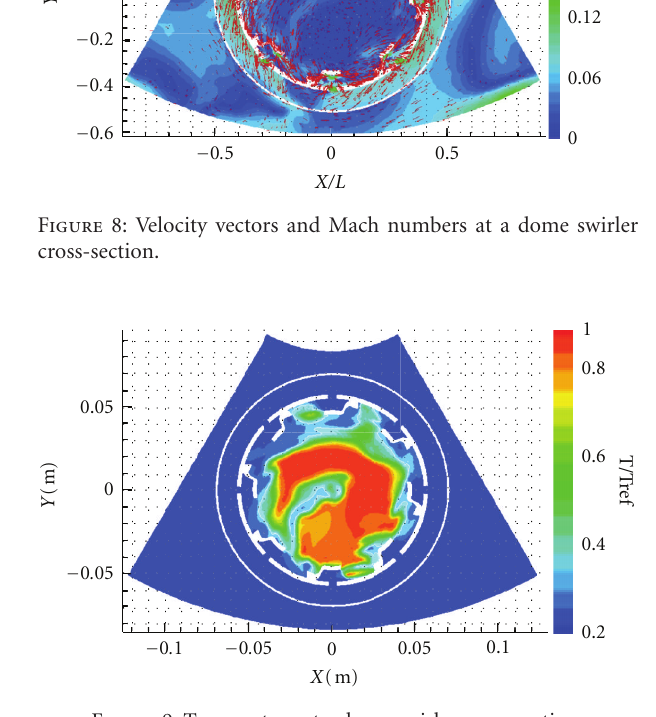
Figure 9: Temperature at a dome swirler